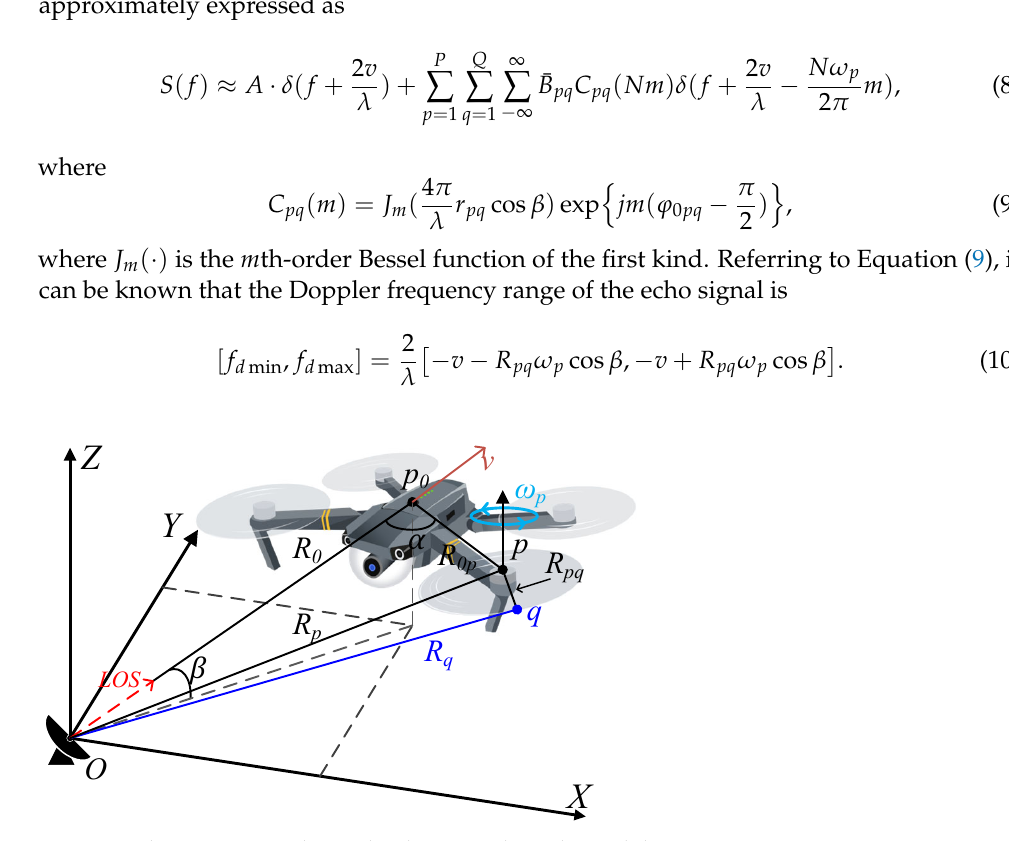
Figure 1. The geometric relationship between the radar and